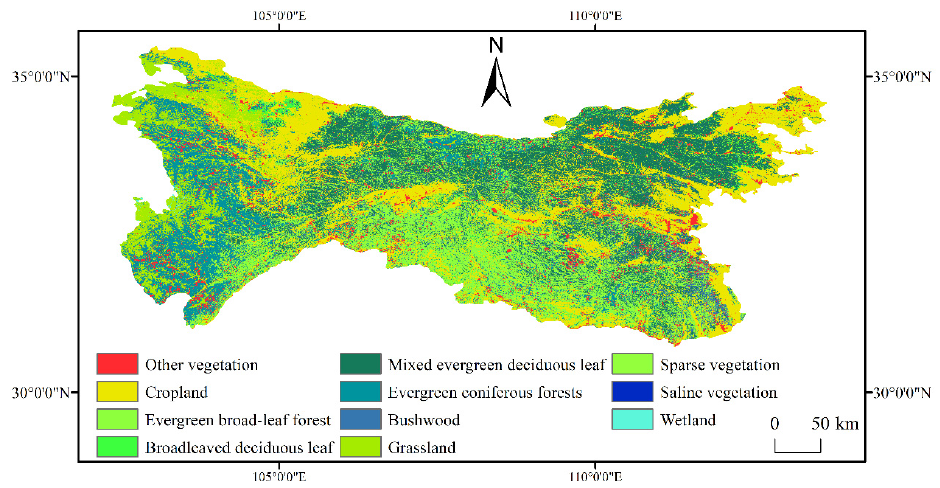
Figure 2. Vegetation-type distribution in the Qinling-Daba mountains from 1982 to 2015.